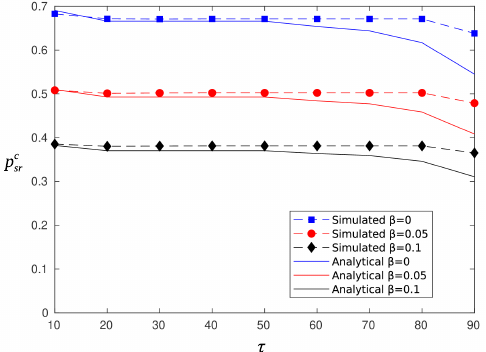
Figure 7. Probability of successful reporting, p c sr , for circular selection of sectors.